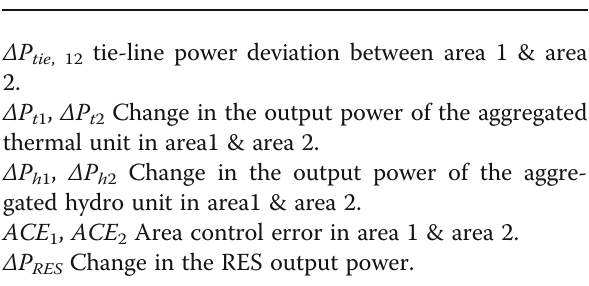
Table 4 Calculated values of fitness function (13) for scenario 3 Scenario Without any LFC Scheme